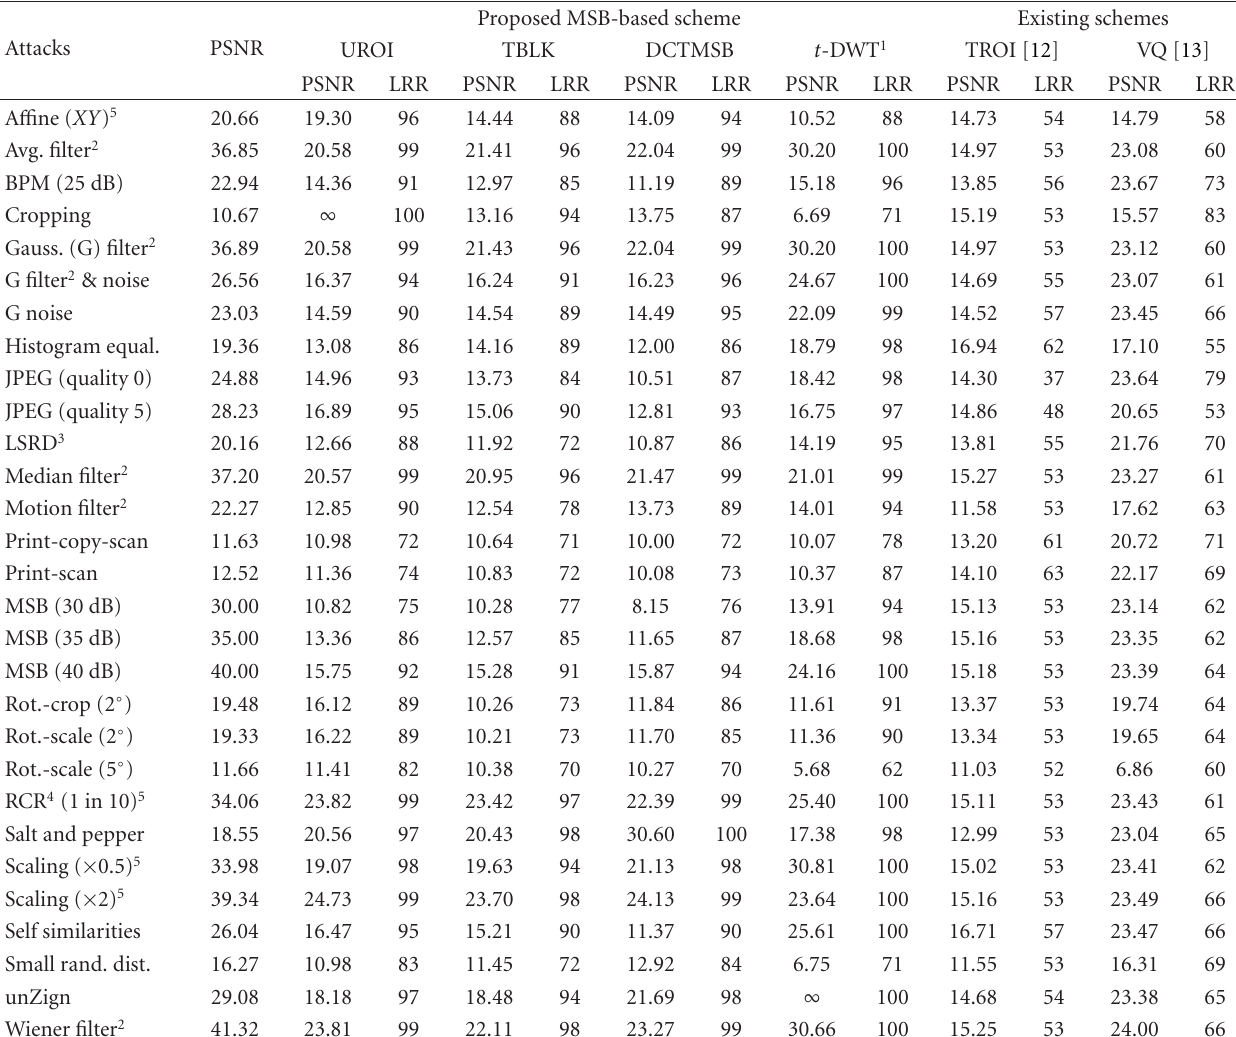
Table 2: Experimental results (PSNR in dB and LRR in %) by di ff erent approaches of the proposed MSB-based scheme and existing TROI- based [12] and VQ-based [13] schemes against various attacks using Lena image and Monash